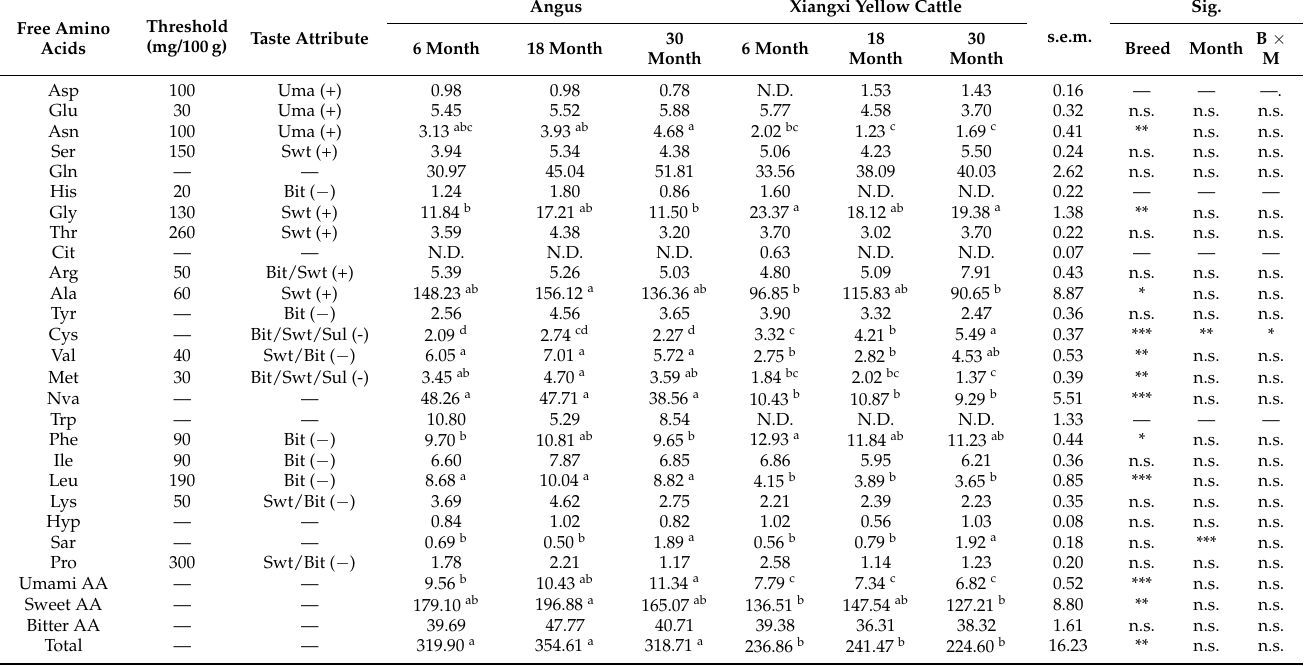
Table 1. Free amino acid concentrations (mg/100 g) determined in LT muscle from Angus and Xiangxi yellow